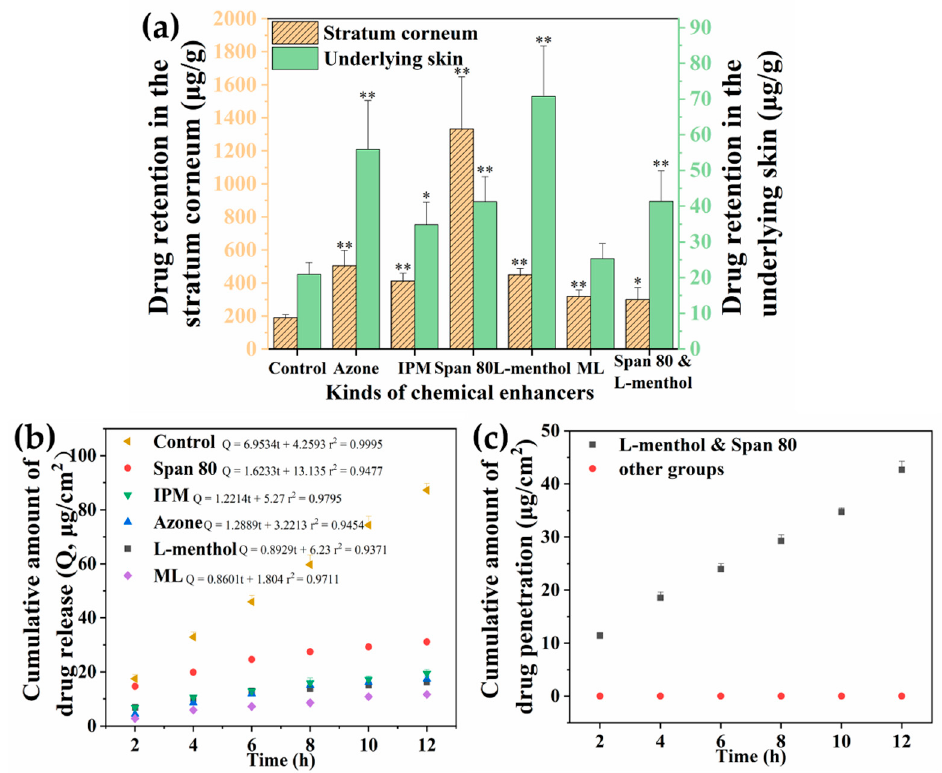
Figure 6. ( a ) Effects of chemical enhancers on the AA content in the stratum corneum and the remaining skin; ( b ) effects of chemical enhancers on the release of AA; ( c ) effects of chemical enhancer combination (L-menthol and Span 80) on the AA content in receptor fluid compared with other groups (including the control group of 0.1 mol eq DEtA added AA-loaded hydrogel and other groups including the hydrogels containing only one kind of enhancers, i.e., Azone, IPM, Span 80, L-menthol and ML (IPM: isopropyl myristate; ML: menthyl Lactate; *: p < 0.05; **: p < 0.01).